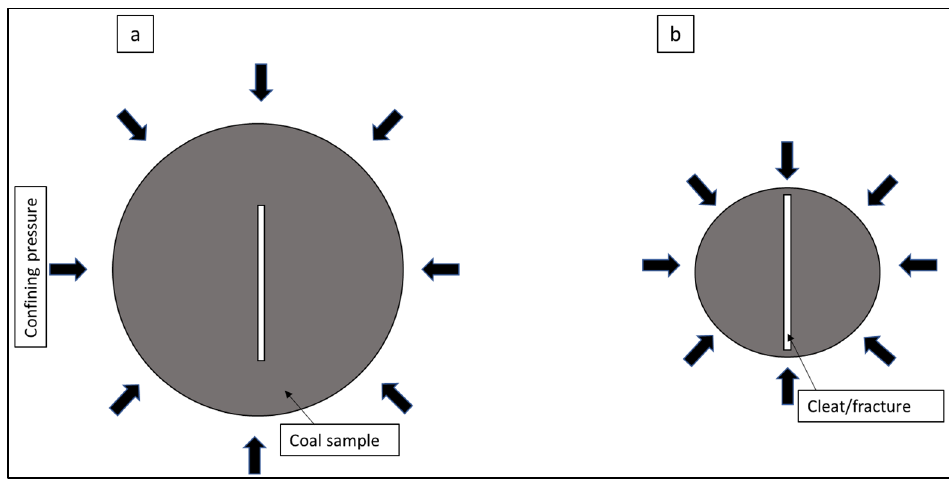
Figure 26. Cross-sections of two cylindrical coal samples (a large arrow means confining pressure is applied). is